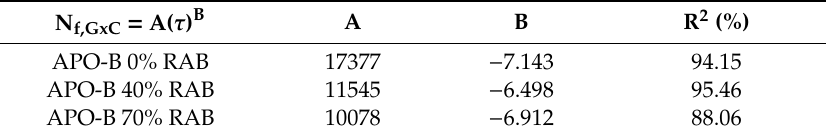
Figure 9. Fatigue curves of the three bituminous mortar mixtures, based on the N f,G*xC criterion. Table 6. Fatigue test parameters of tested mortar mixtures.